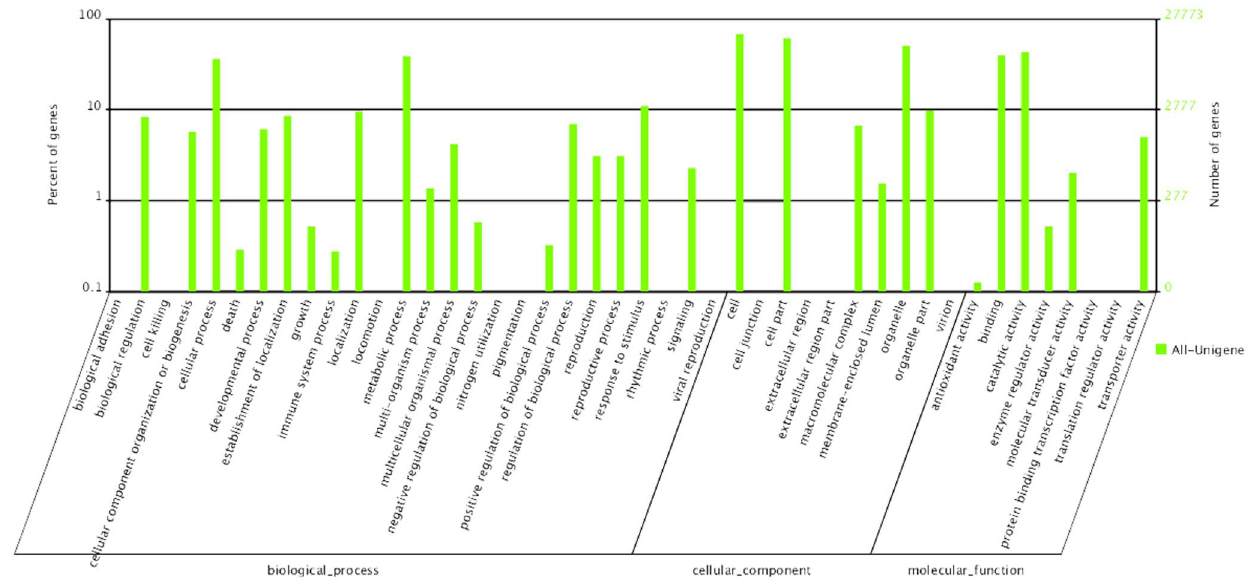
Figure 4. GO categories of the unigenes. The unigenes were annotated in three categories: biological processes, cellular components and molecular functions.